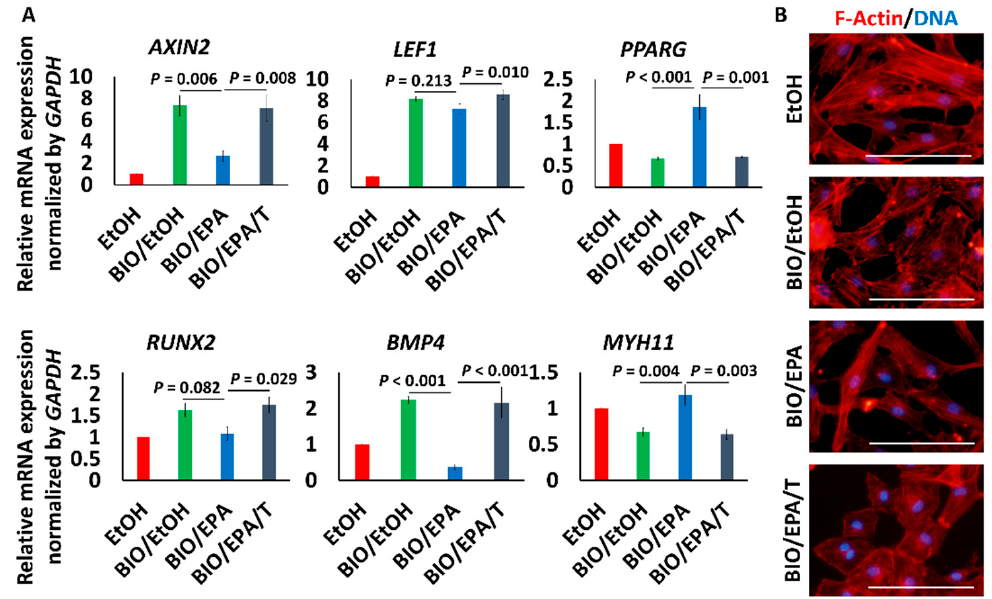
Figure 4. Effects of EPA on β -catenin signaling stimulated by GSK-3 inhibitor. ( A ) Changes of the gene expression pattern in HAoSMCs treated with 1 μ mol/L BIO, with or without EPA/T0070907. Data are shown as means ± SE ( n = 4 in each group) and were analyzed using one-way ANOVA with Tukey’s post hoc test. T means T0070907 (10 μ mol/L); ( B ) Morphological changes of HAoSMCs. Red and blue represent f -actin and DNA, respectively. Bar = 100 μ m.